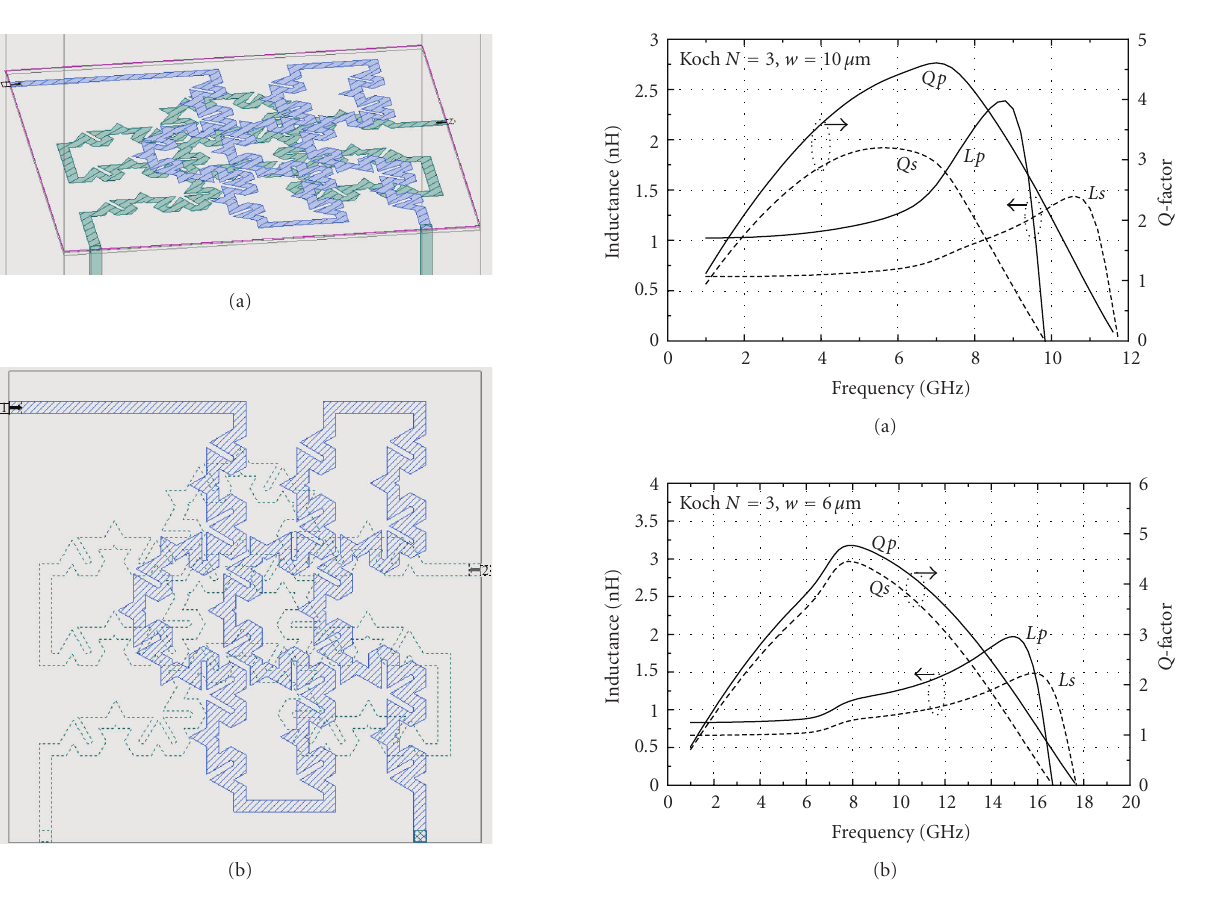
Figure 10: A Koch fractal transformer, (a) 3D view (b) the top view. Figure 11: Dependence of Q -factor and inductance as a function of frequency for transformer with (a) w p = w s = 10 μ m, (b) w p = w s = 6 μ